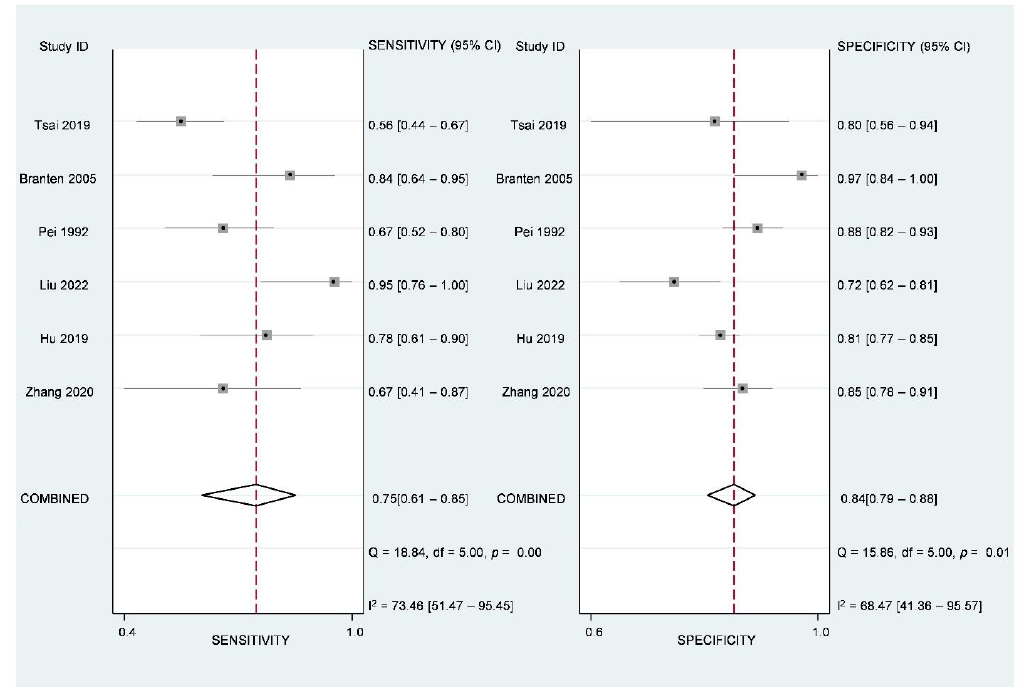
Figure 4. Forest plots of the pooled sensitivity and specificity with corresponding 95% CIs of the six prediction models with renal function deterioration as predicted outcomes.